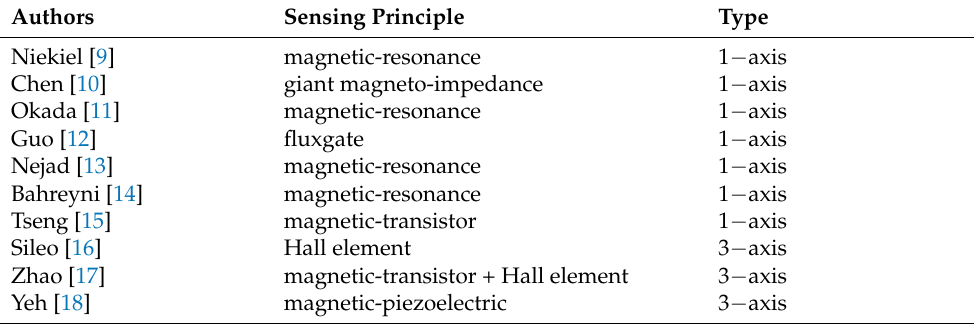
Table 1. Summary of sensing principle and type for various micro magnetic